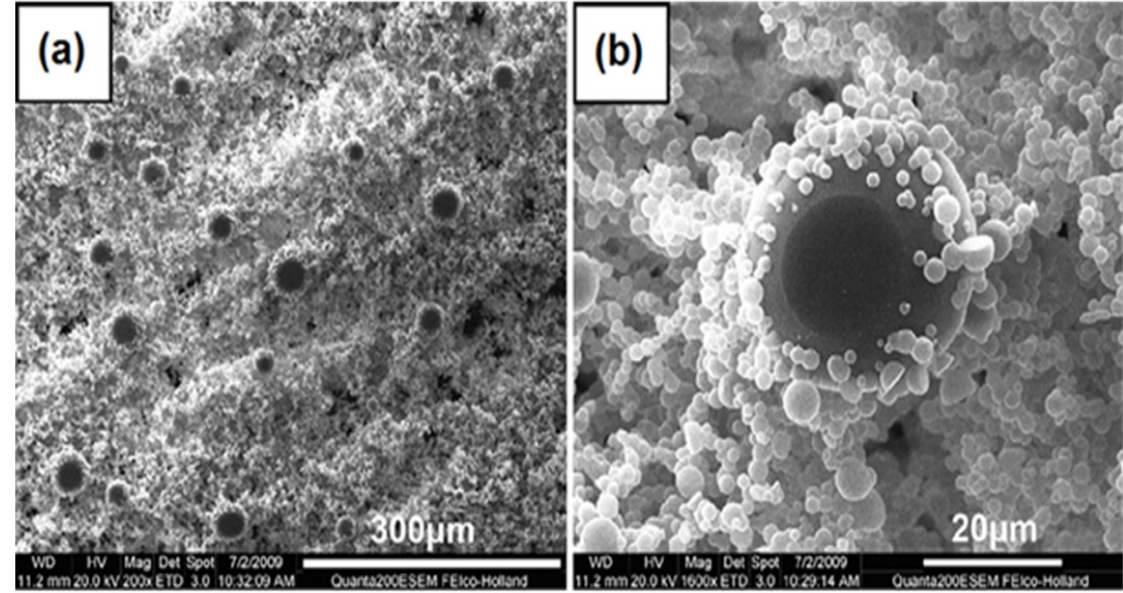
Figure 16. ( a ) Low and ( b ) high magnification SEM images of the copolymer film prepared from 50% ( v/v ) ethanol content in copolymer solution. Images reprinted from [119], with permission from Elsevier, Copyright